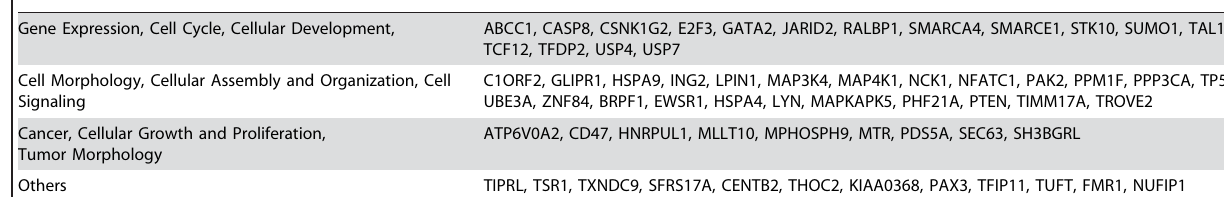
Table 5. ‘Stemness genes’*